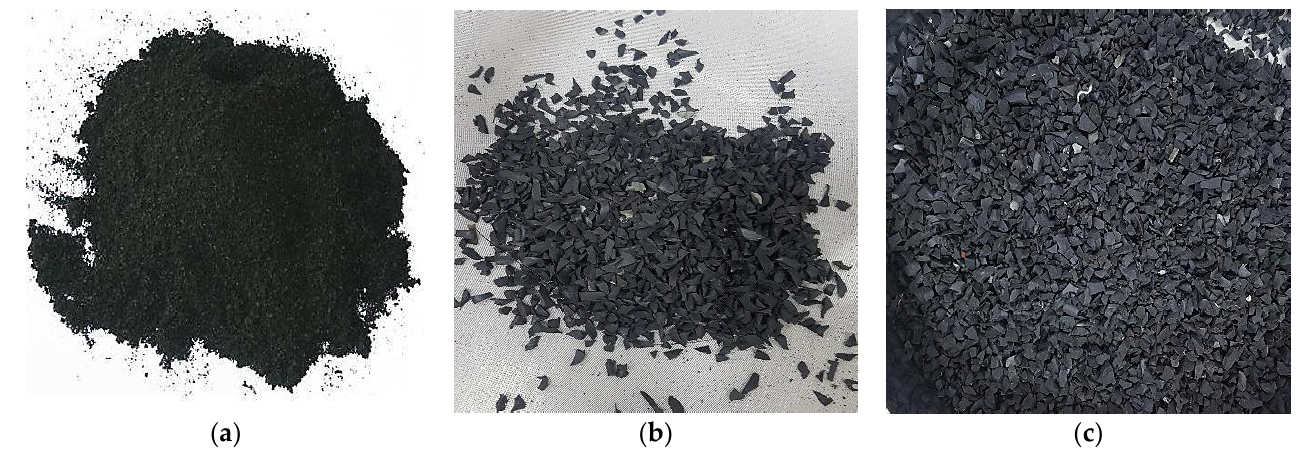
Figure 2. Rubber waste: ( a ) R1, ( b ) R5, ( c )